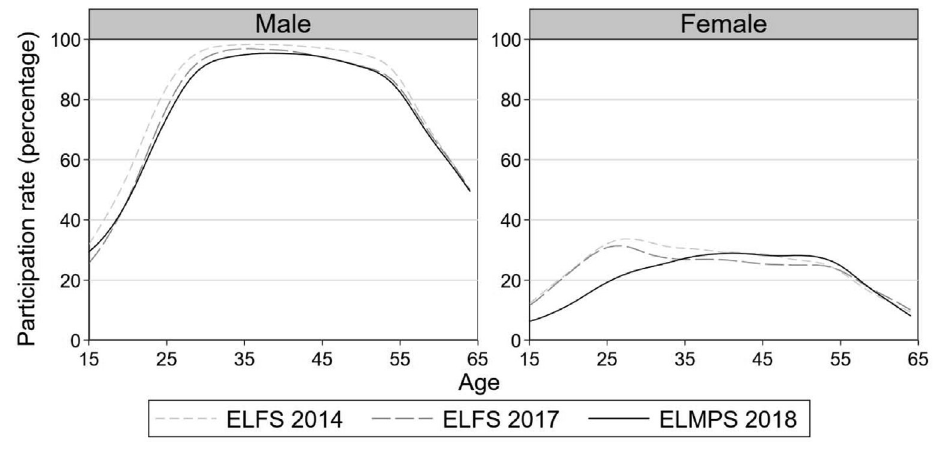
Source : Authors’ calculations from LFS 2014, 2017, and ELMPS